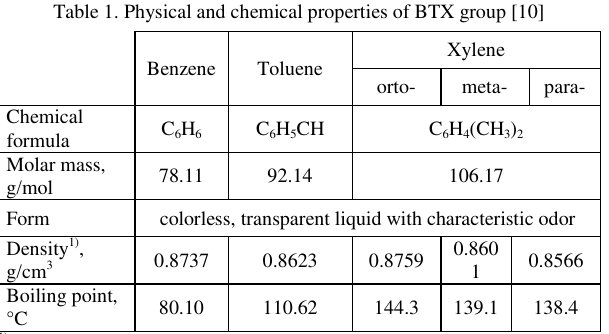
Table 1. Physical and chemical properties of BTX group [10]